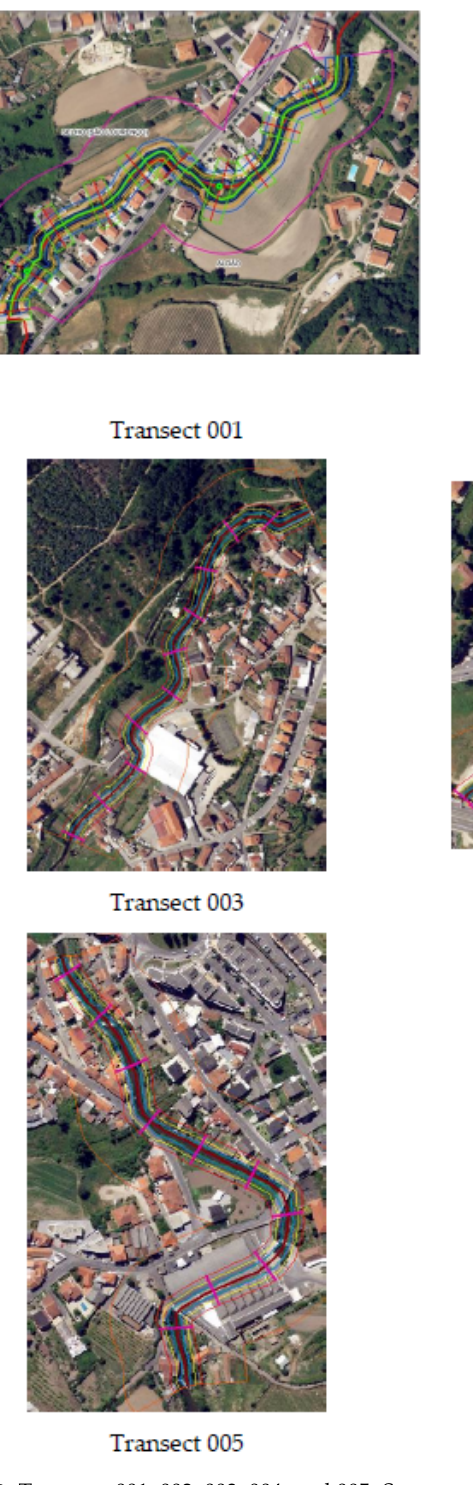
Figure 3. Transects 001, 002, 003, 004, and 005. Source: orthophotos provided by the Municipality of Guimar ã es